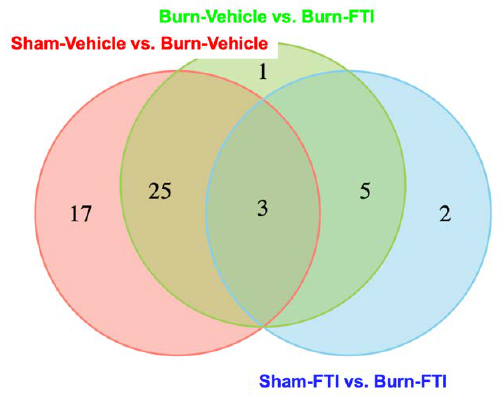
Figure 3. The intersection of differential metabolites. Venn diagram illustrates the distribution of differential metabolites showing significantly ( p < 0.05 by Wilcoxon test) modulated levels. Red, blue and green circles indicate differential metabolites between Sham-Vehicle vs. Burn-Vehicle, those between Sham-FTI vs. Burn-FTI, and those between Burn-Vehicle vs. Burn-FTI, respectively.